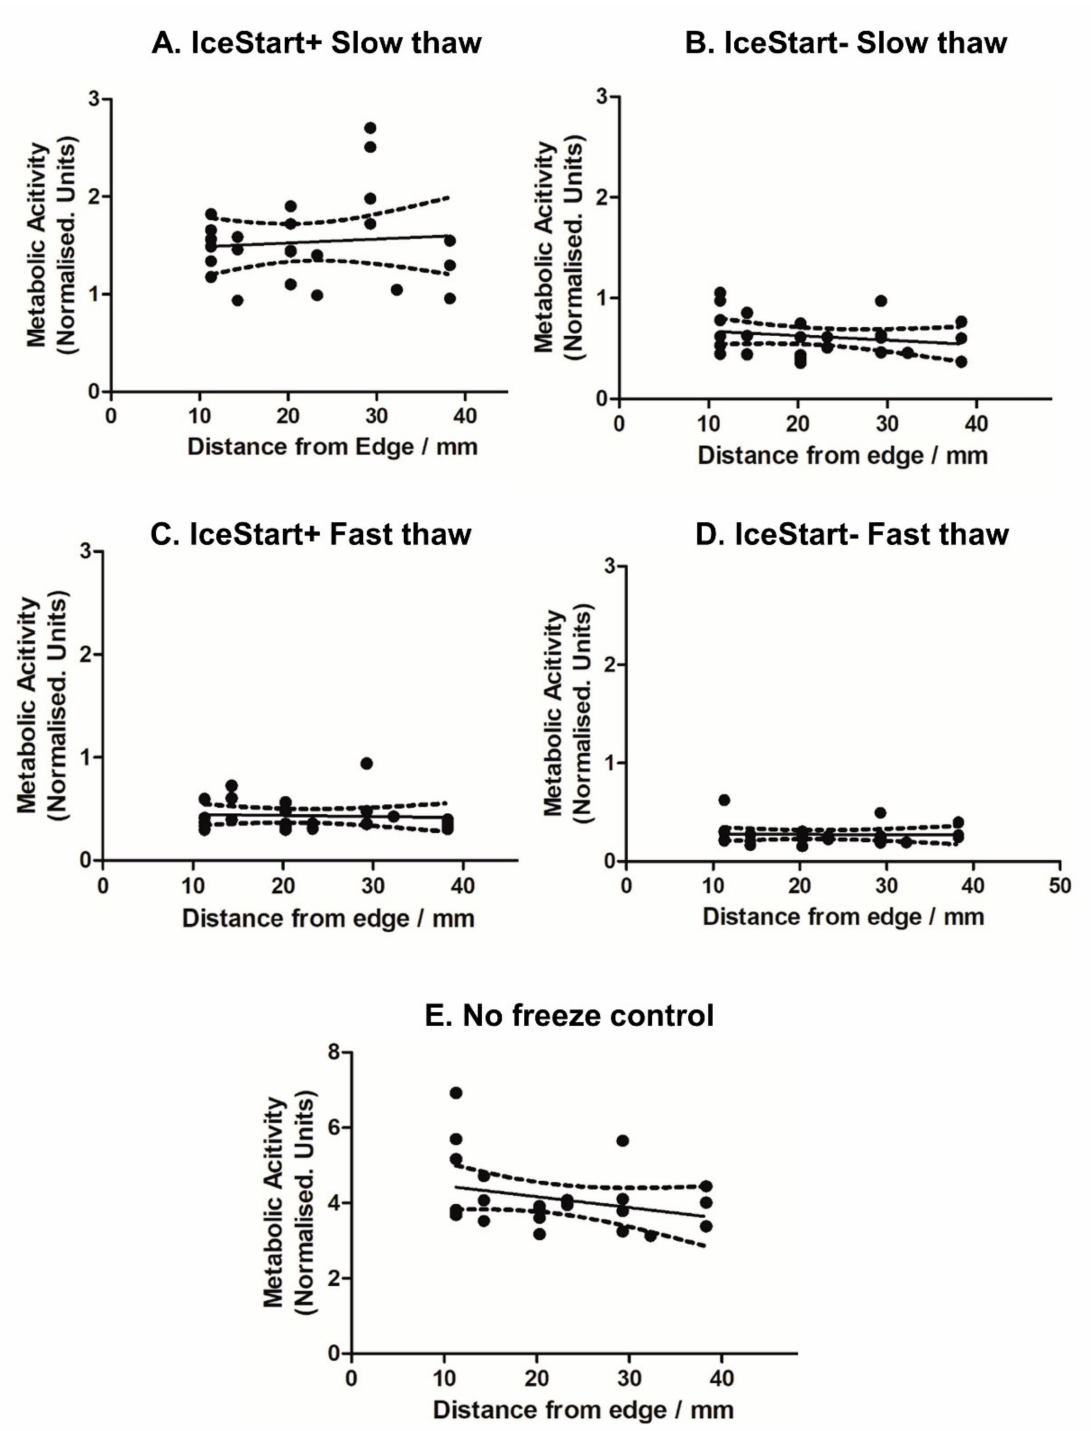
Figure 5. Linear regression with 95% confidence intervals of Day 4 metabolic activity (normalised to Day 1 No Freeze control values for each well respectively). ( A ) IceStart + slow thaw (ST), ( B ) IceStart − ST, ( C ) IceStart + fast thaw (FT), ( D ) IceStart − FT, ( E ) No Freeze control. Frequency of well position values vary due to di ff erent replicate positions across a 96-well plate. Mean values calculated from n = 3 donor repeats for each well